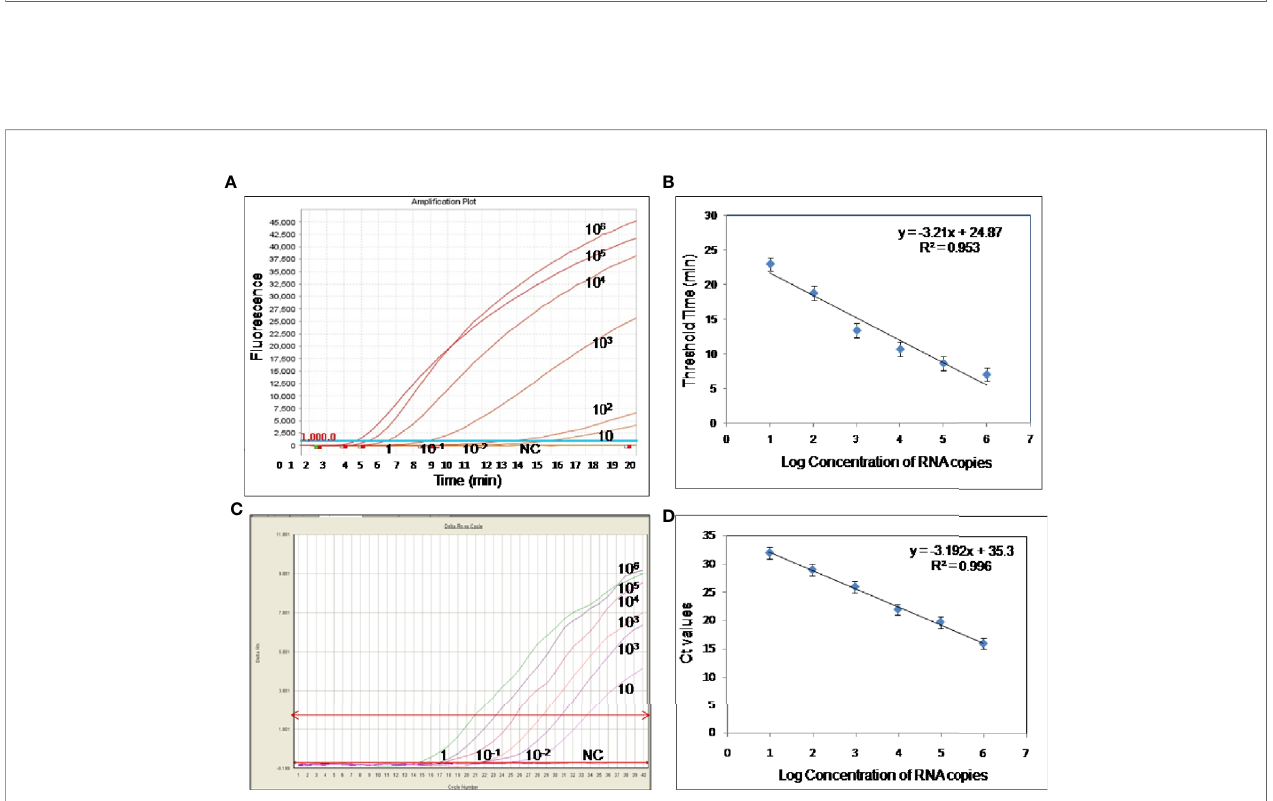
FIGURE 3 | Sensitivity evaluation of real-time reverse transcription recombinase polymerase ampli fi cation (RT-RPA) and RT-qPCR assay using tenfold serial dilution of West Nile virus (WNV) targeted in-vitro transcribed RNA. (A) Ampli fi cation plot of real-time RT-RPA assay (B) Standard curve for real-time RT-RPA assay plotted between the threshold time values and log concentration of RNA copies (C) Real-time kinetics of real-time RT-PCR (D) Standard curve for real-time RT-PCR assay plotted between the Ct values and log concentration of RNA